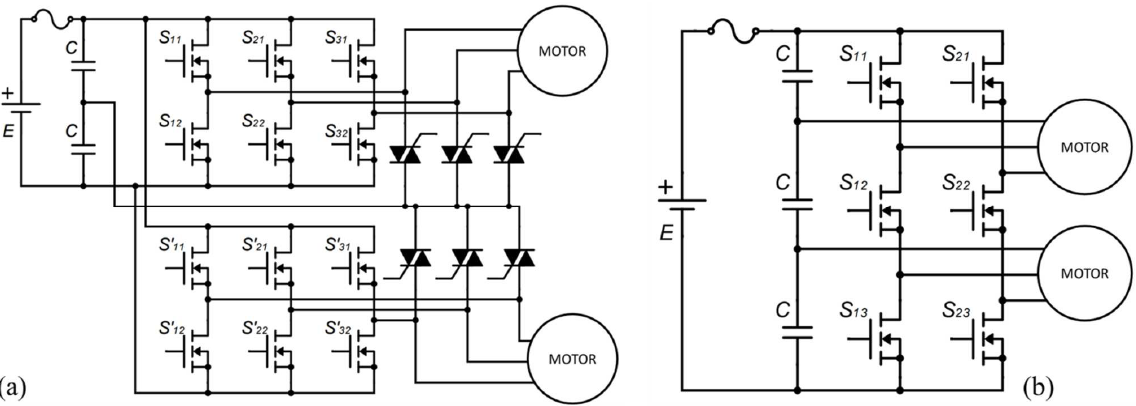
Figure 10. DCM strategy applied to: ( a ) Conventional topology [74], ( b ) Shared arm topology [76].